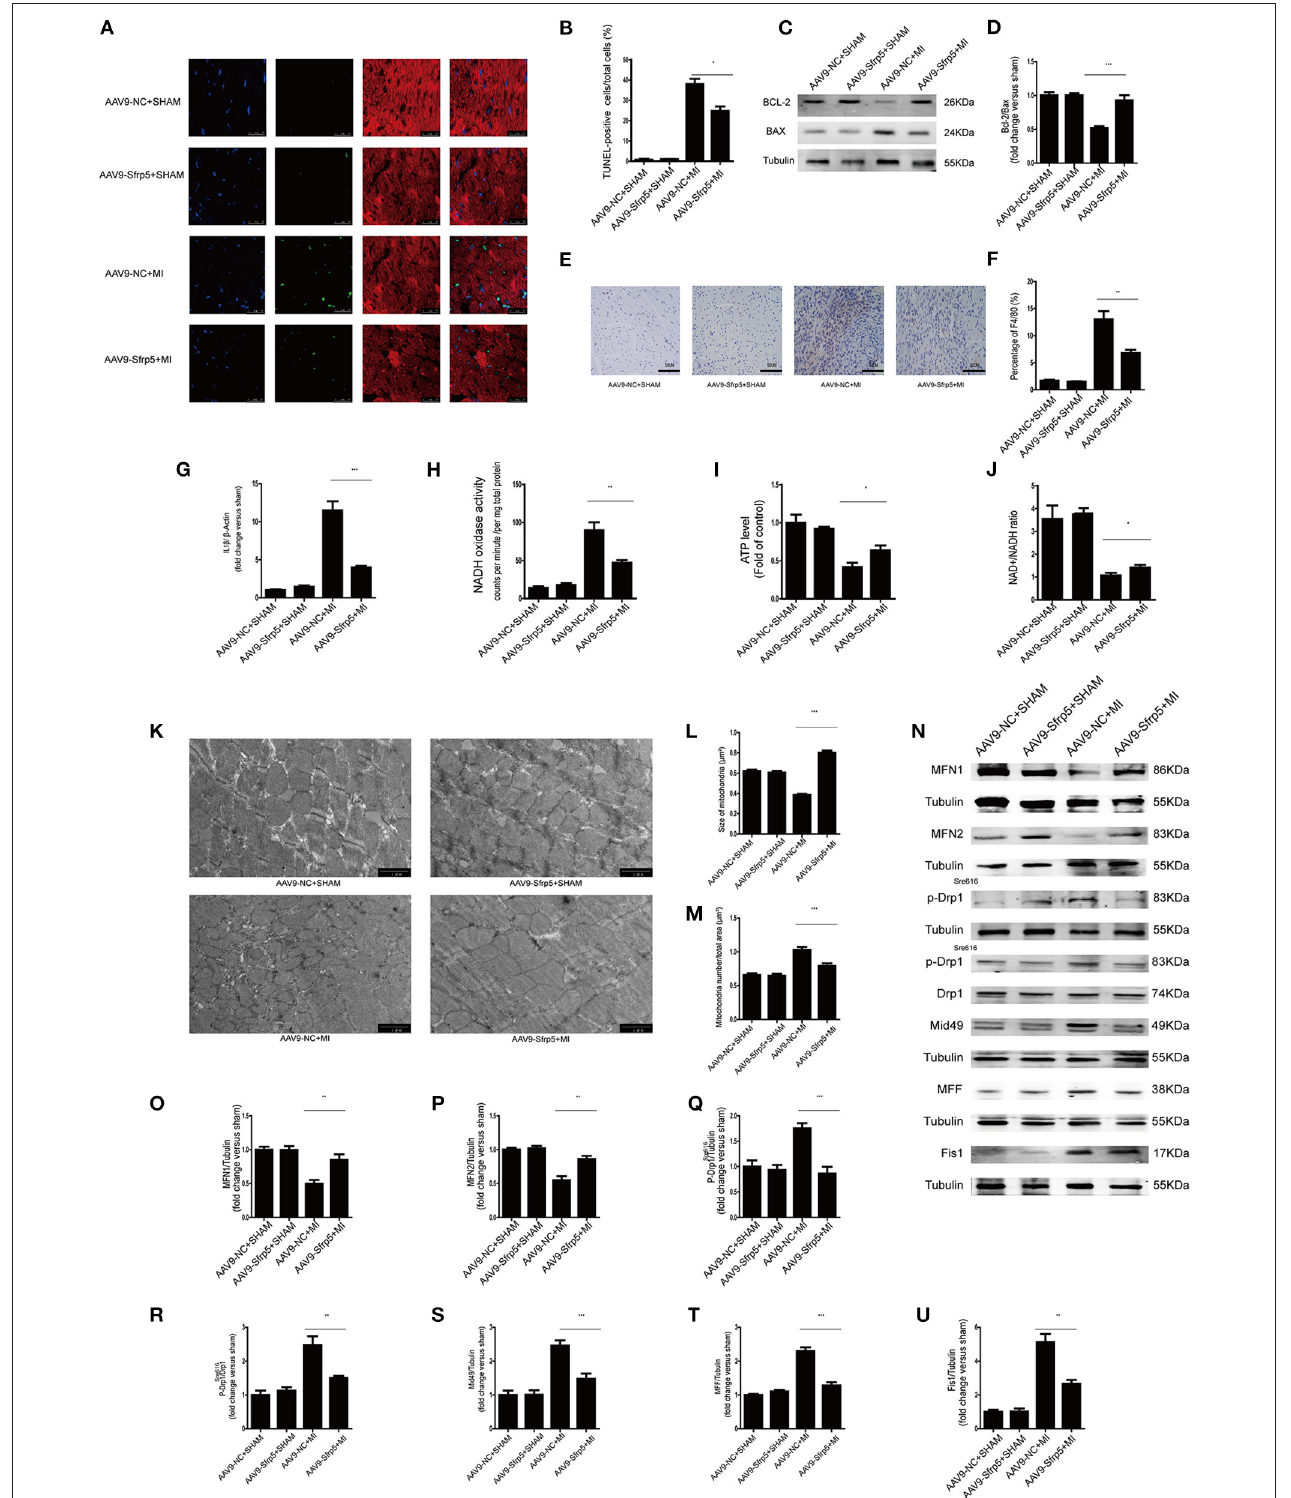
FIGURE 4 | Sfrp5 decreased apoptosis and improved mitochondrial dysfunction. (A) Cardiomyocyte apoptosis determined by TUNEL staining. Scale bars = 25 µ m. (B) Statistical analysis of TUNEL-positive cells (values are presented as mean ± SD, n = 6 per group). (C) Protein expression of Bax and Bcl-2 in mouse hearts at